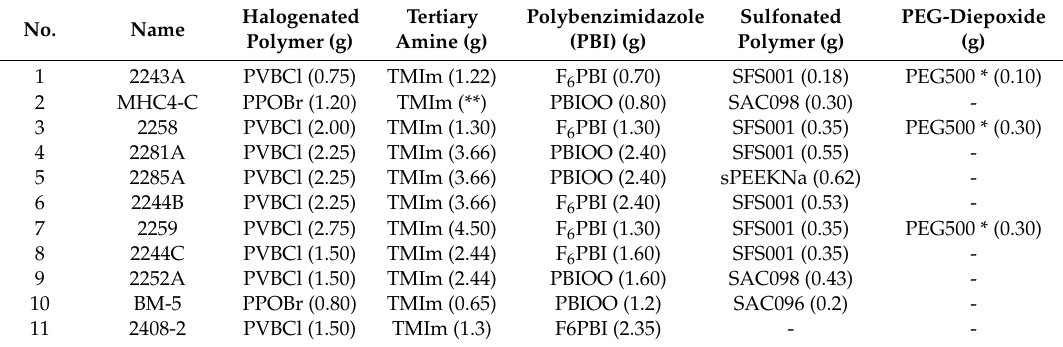
Table 2. The di ff erent polymer mixtures used in the synthesis of the novel anion exchange